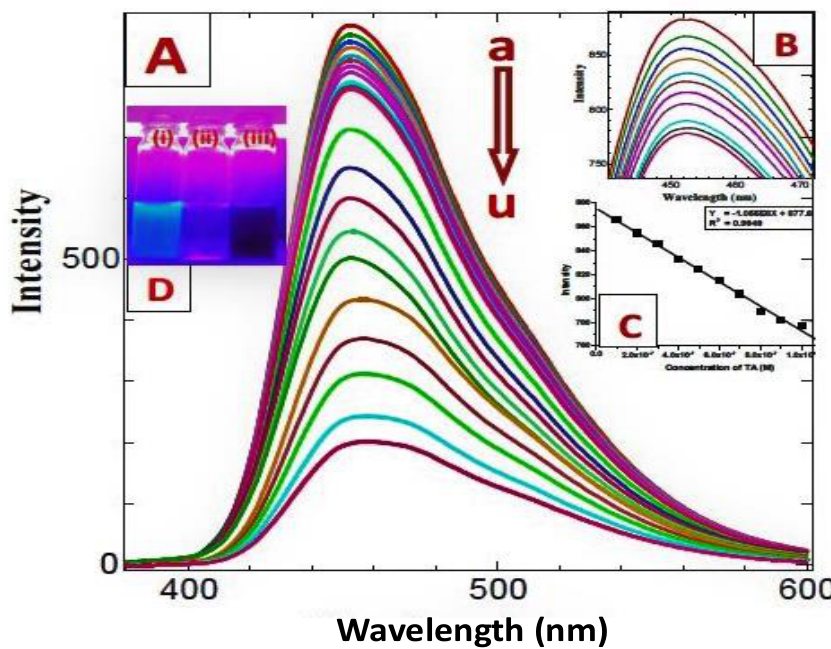
Figure 8. Fluorescence emission spectra of GQDs in the presence of different tannic acid (TA) concentrations, from 0.1 to 50 µ M. The inset shows the linear plot of the intensity versus TA concentration. Taken from Sinduja et al. [179].